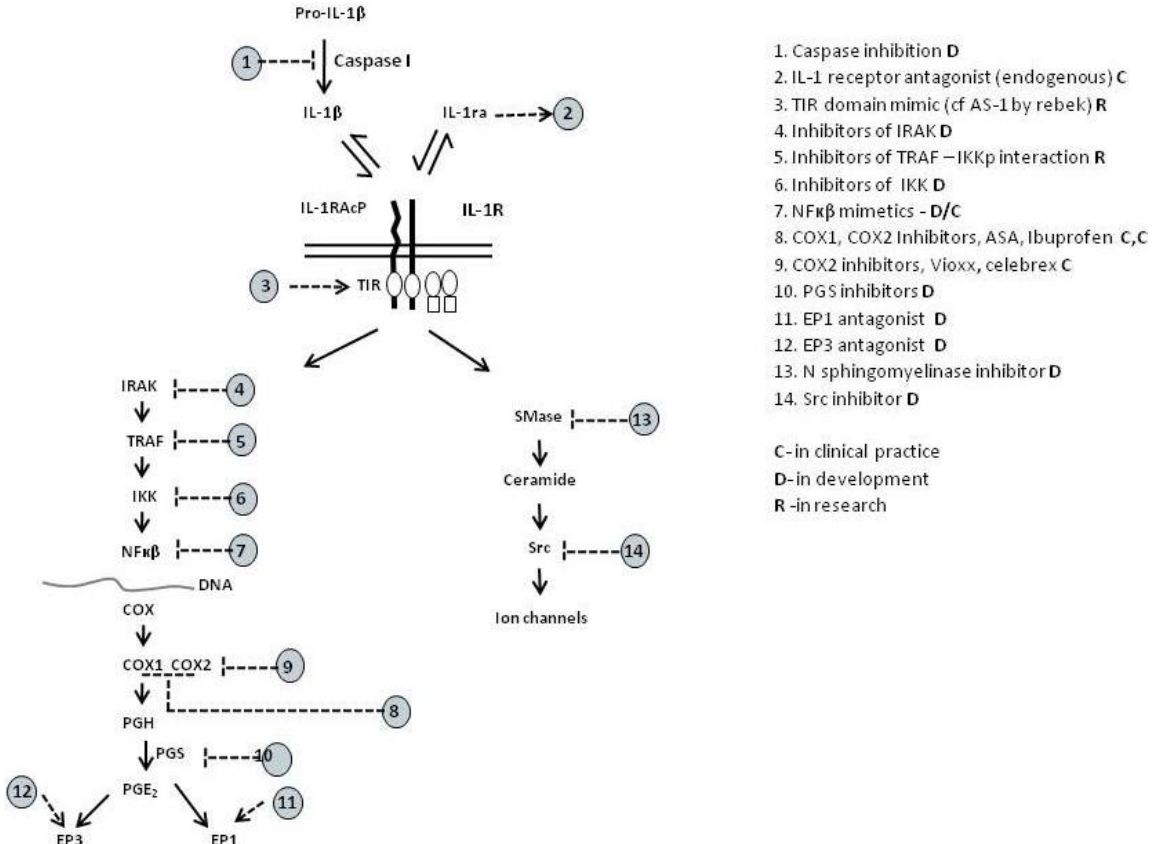
FIGURE 5. The sites of action of antipyretics in clinical practice and in development. Schematic representation of the site of action of antipyretic drugs in clinical practice, in development, or still being investigated.